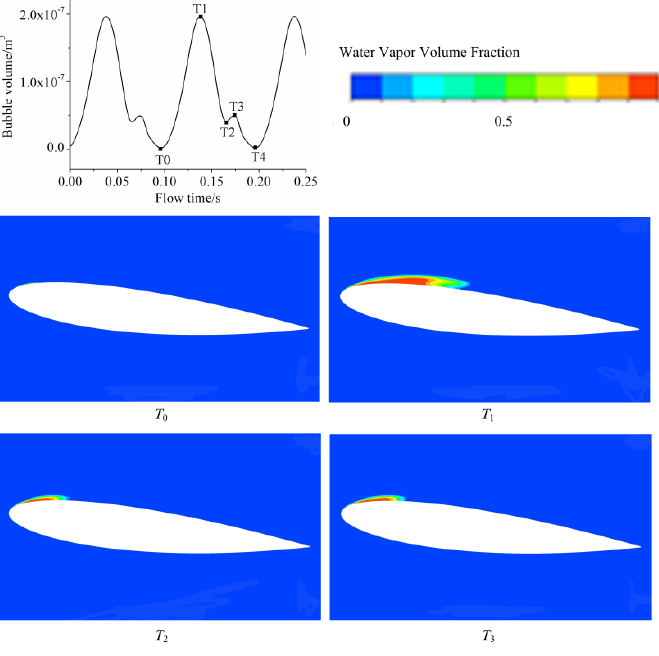
Figure 9. Bubble volume pulsation and numerical results for σ = 0.975.